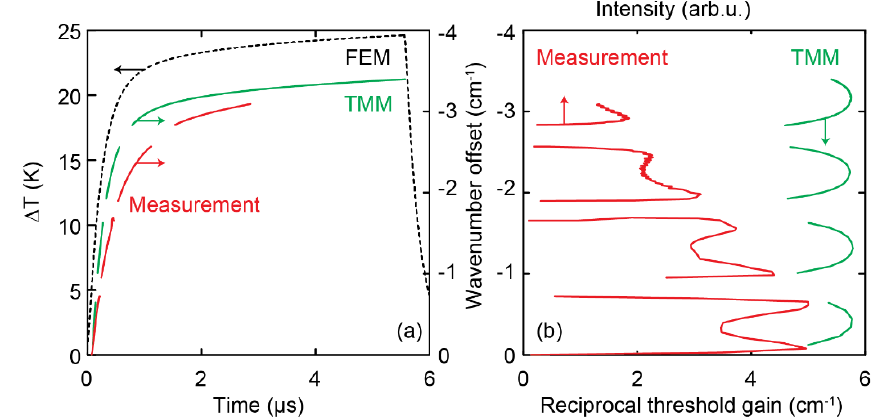
Figure 5. Comparison between a measured and simulated iCW operation of a dual DFB section. ( a ) The average temperature offset extracted from thermal finite element situation (black, dashed), frequency offset extracted from TMM calculations (green) and measurement (red) as a function of iCW pulse duration. ( b ) Comparison of the same measurement and simulation data displayed in (a), plotted in function of intensity and reciprocal threshold gain, respectively.